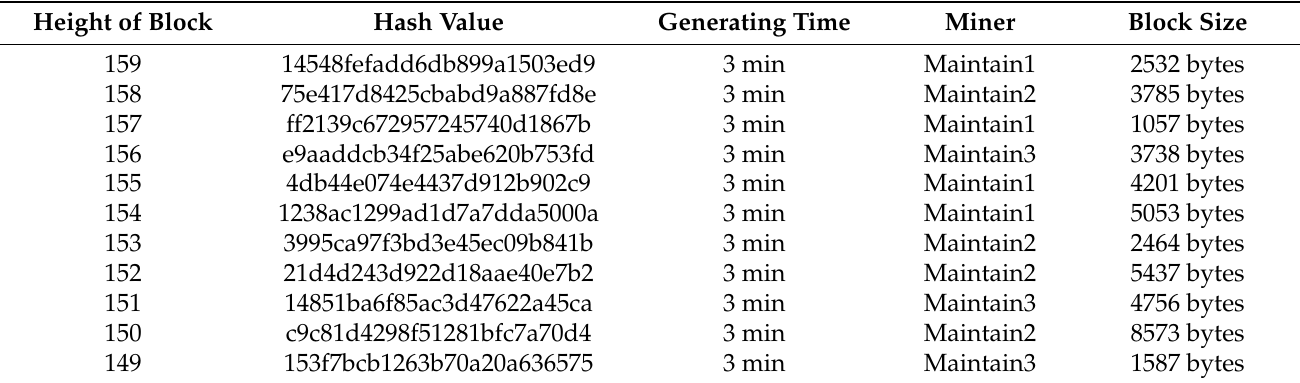
Table 3. Blockchain information of BNCM.